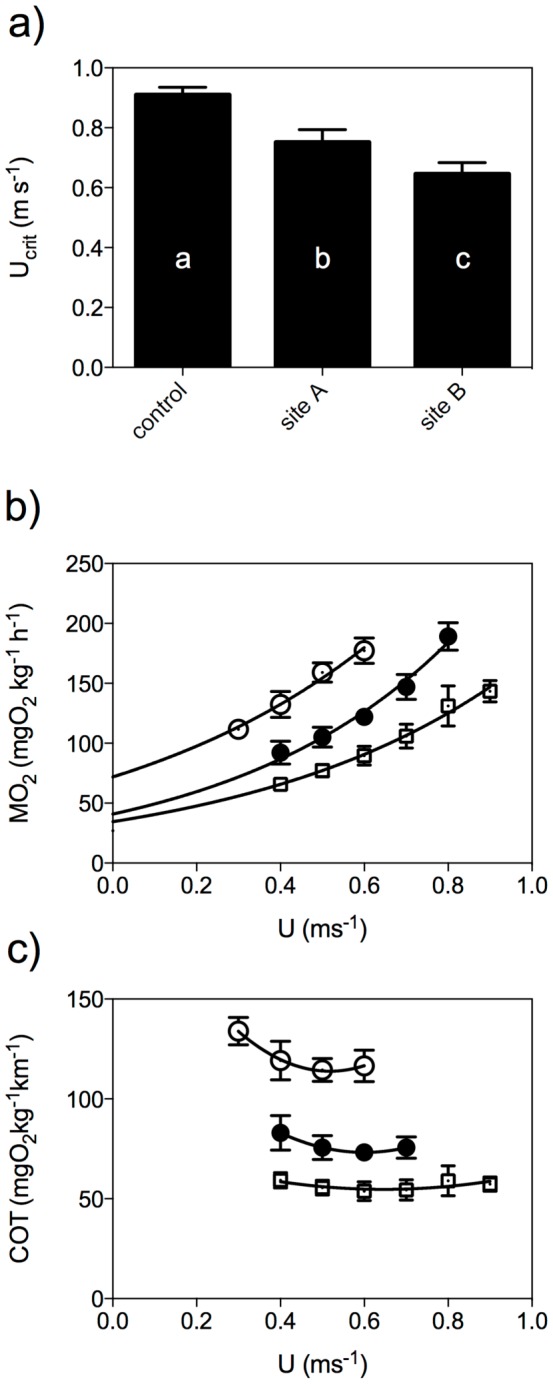
Swimming energetic parameters with increasing drag.a) Critical swimming speed (Ucrit), b) relative oxygen consumption (MO2, mgO2kg−1h−1) and c) Cost Of Transport (COT, mgO2kg−1m−1), both as a function of swimming speed (U, m s−1) for the first (□) and second control (⋄), and for eels carrying the support device (▵), a small (•), intermediate (•) and a large (•) dummy at site A. Exponential function MO2  =  SMRecU, with SMR the standard metabolic rate, e Euler's constant and c constant, and U swimming speed (for values see table 1). Data are mean±SE, repeated measures ANOVA, p<0.05, N = 8, r2>0.9, * indicates significant difference from control at the respective speed.